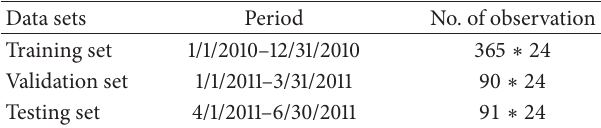
Table2:Training,validation,andtestingsetforthefirstsamplecase.